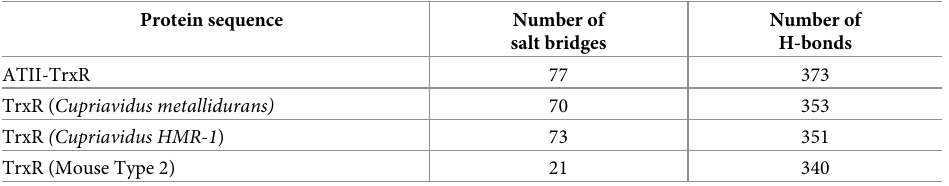
Table 2. Predicted number of salt bridges and H-bonds in ATII-TrxR enzyme and the corresponding enzyme